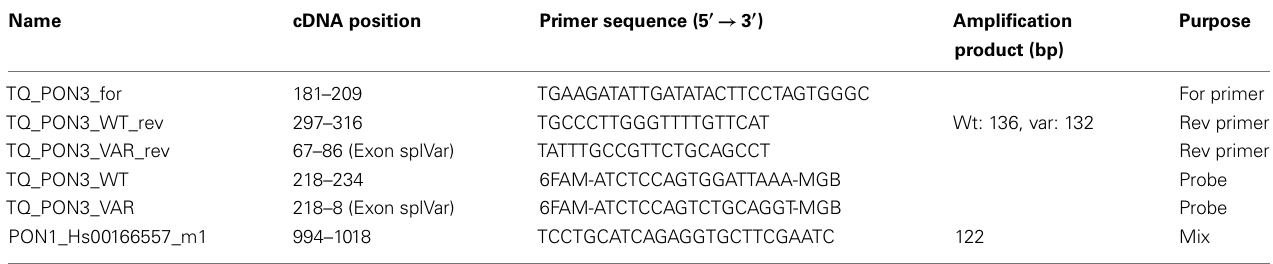
TableA2 | Amplification primers used for quantitative PCR.